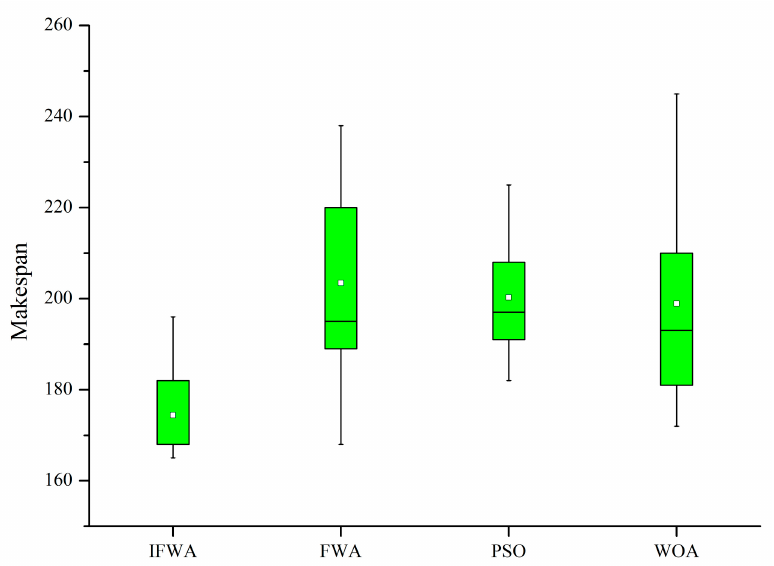
Figure 5. Boxplot for the instance of the HFSP.